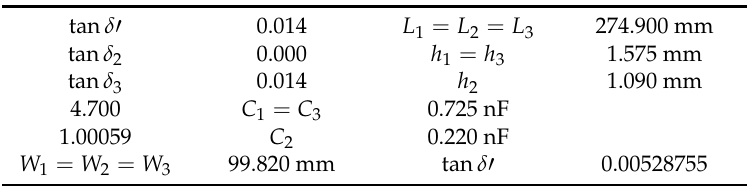
Table 7. Parameters and results.